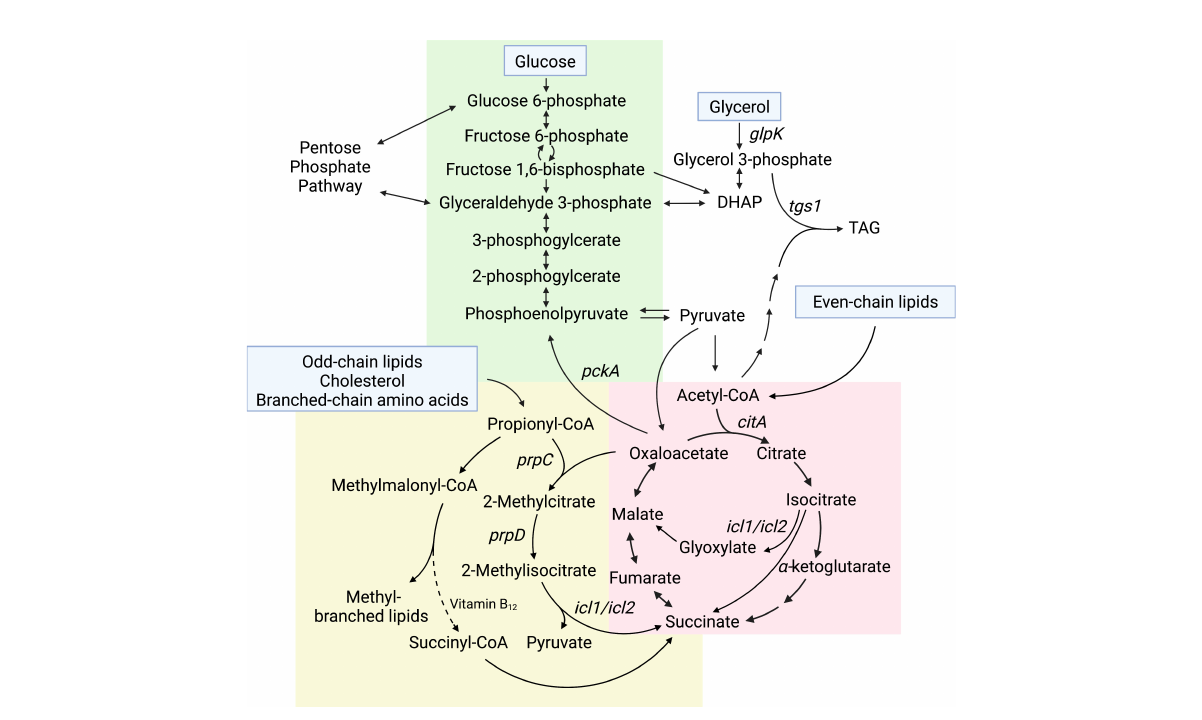
FIGURE 1 Core central carbon metabolism pathways that impact Mtb drug sensitivity. Carbon sources that feed into Mtb central carbon metabolism are listed in blue boxes. Carbon fl owing down the pathway from glucose toward pyruvate, indicated by the downward pointing arrows, is glycolysis, whereas the reverse pathway, indicated by upward pointing arrows, is gluconeogenesis (green background). Even-chain lipids feed into the TCA cycle (red background). Odd-chain lipids, cholesterol, and branched-chain amino acids feed into the MCC and methylmalonyl-CoA pathways (yellow background). Genes discussed in the text that impact antibiotic sensitivity are indicated on the